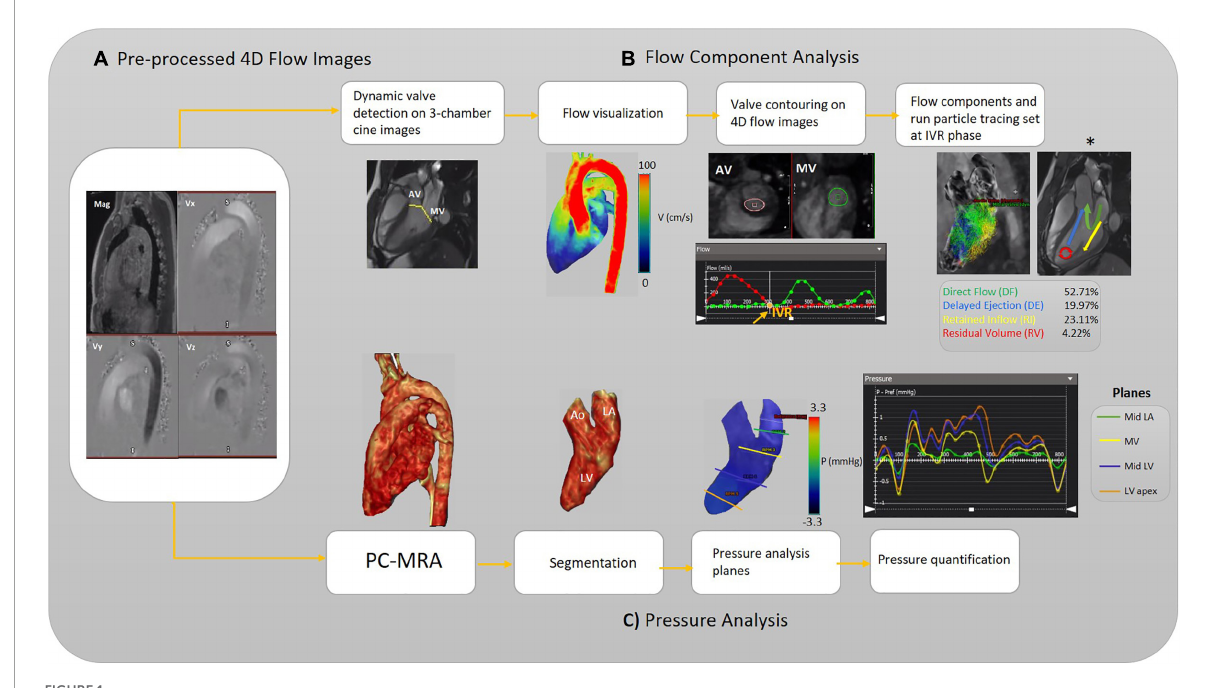
FIGURE1 Workflow illustration. (A) Pre-processing of the raw 4D-flow data. (B) Analyzing flow components. The different left ventricular (LV) blood flow components are shown schematically (asterisk). (C) Analyzing pressure, including calculation of 3D PC-MRA from the magnitude and 3D velocities to extract the left side of the heart for each subject (3D segmentation). The pressure-time curve is achieved to measure pressure at each pre-defined plane and desired timepoint. Aortic valve (AV), mitral valve (MV), isovolumetric relaxation (IVR), left ventricle (LV), Mid (middle part), left atrium (LA), and phase-contrast magnetic resonance angiography